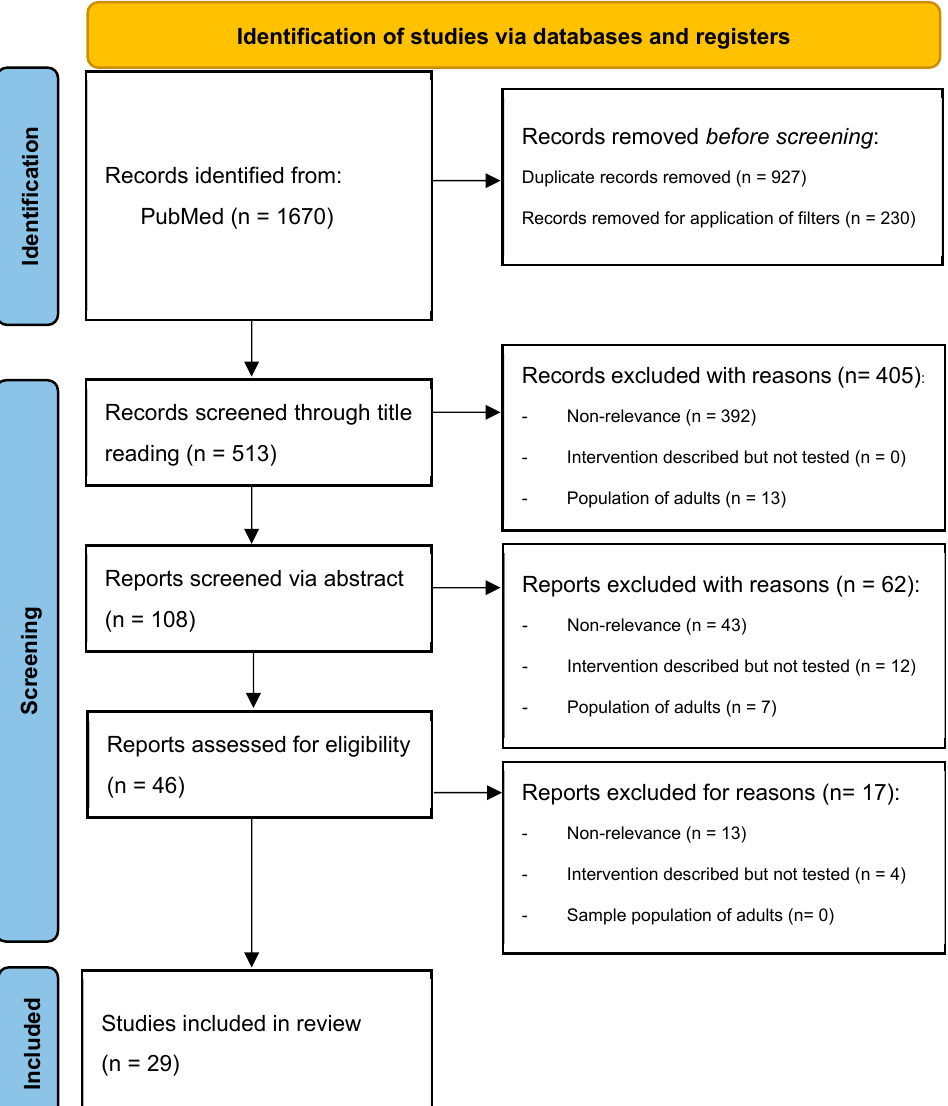
Figure 1. Preferred Reporting Items for Systemic Reviews and Meta-Analyses (PRISMA) 2020 flow diagram.